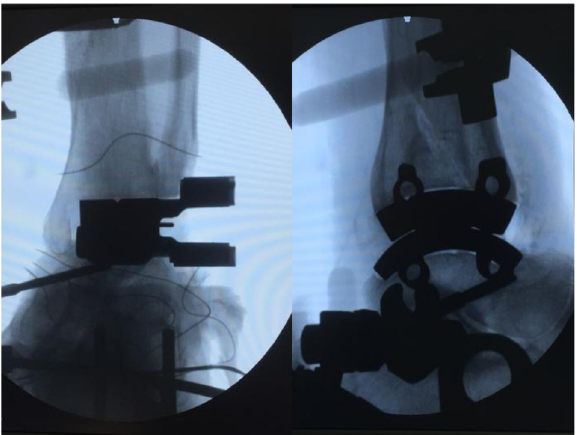
Figure 4. The rail hole drill guides are placed. In the antero- posterior view we confirm that they are medial enough to avoid lateral overhang of the implants. In the lateral view we confirm that they are flush along the talar and tibial cuts. The spreader pin is placed between the